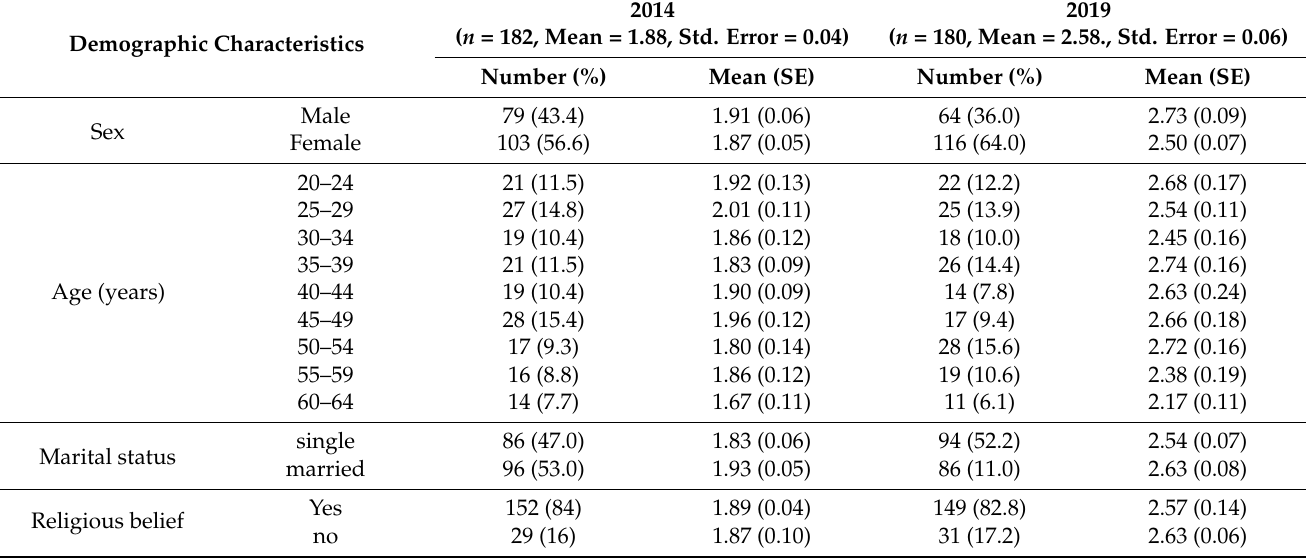
Table 1. Demographic characteristics statistics of knowledge